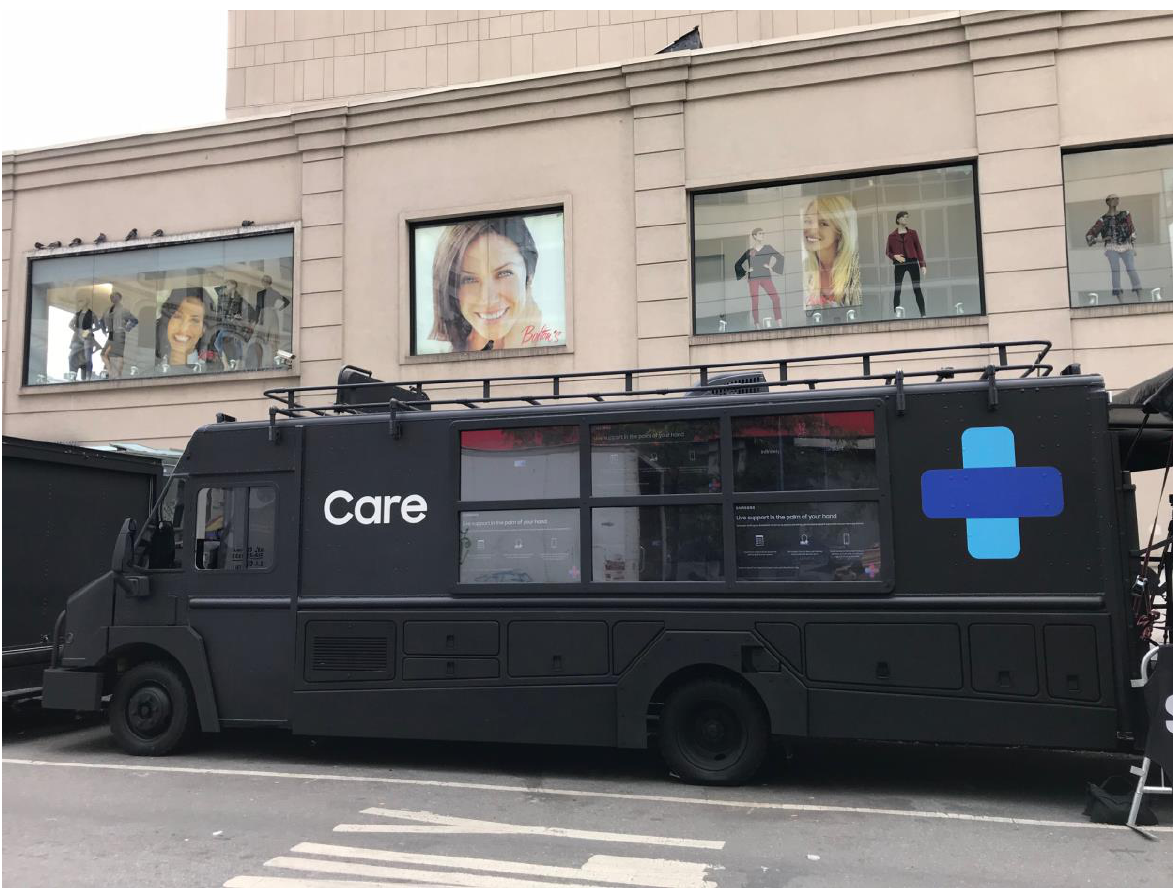
Figure 1. Samsung publicity van. Photo by Matteo